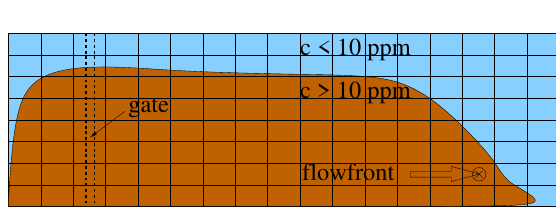
Figure 2. Scheme visualising the definition of the flow front position in the numerical model results.